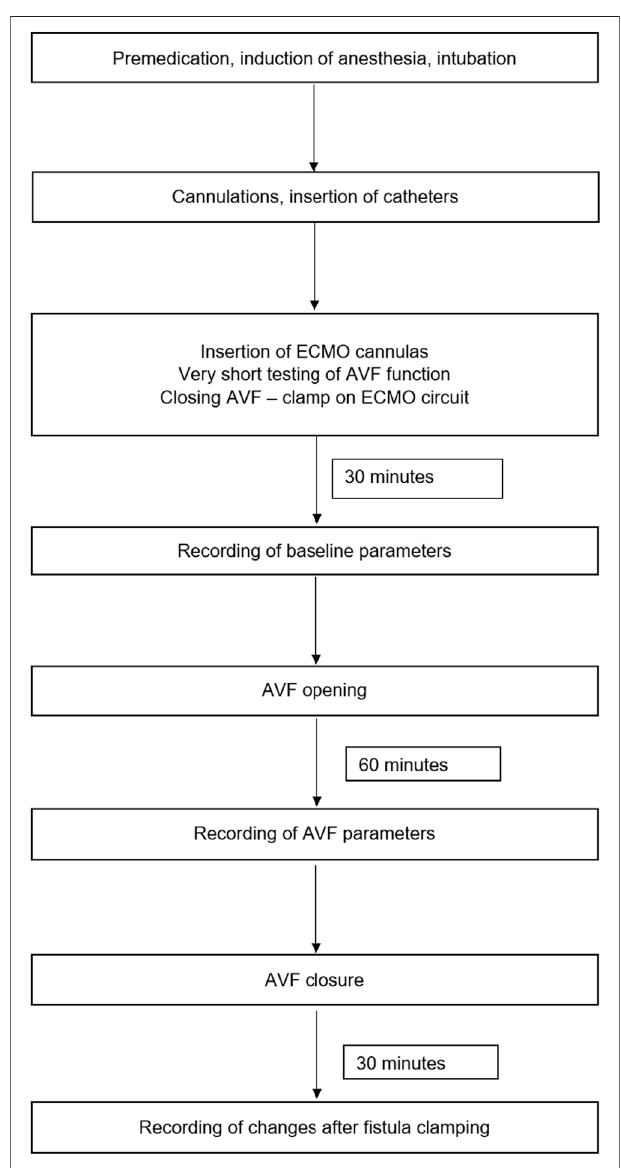
FIGURE 2 | Scheme of study